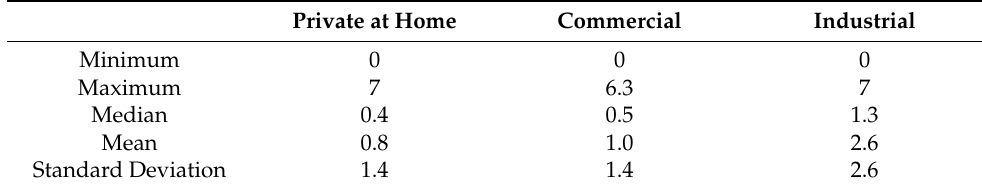
Figure 5. Roasting for preparing cold brew coffee. Next, it was investigated how long the respondents keep the cold brew after extraction. On average, cold brew is kept for 1.5 days, and it can be seen from Table 2 that the maximum time that cold brew is kept is 7 days and the minimum is less than one day. The median for private and commercial groups is about half a day. In industry, the cold brew is kept for about a day (probably, in this case, this is the time before pouring into cans/sterilization). Table 2. Storage time of prepared cold brew coffee (in